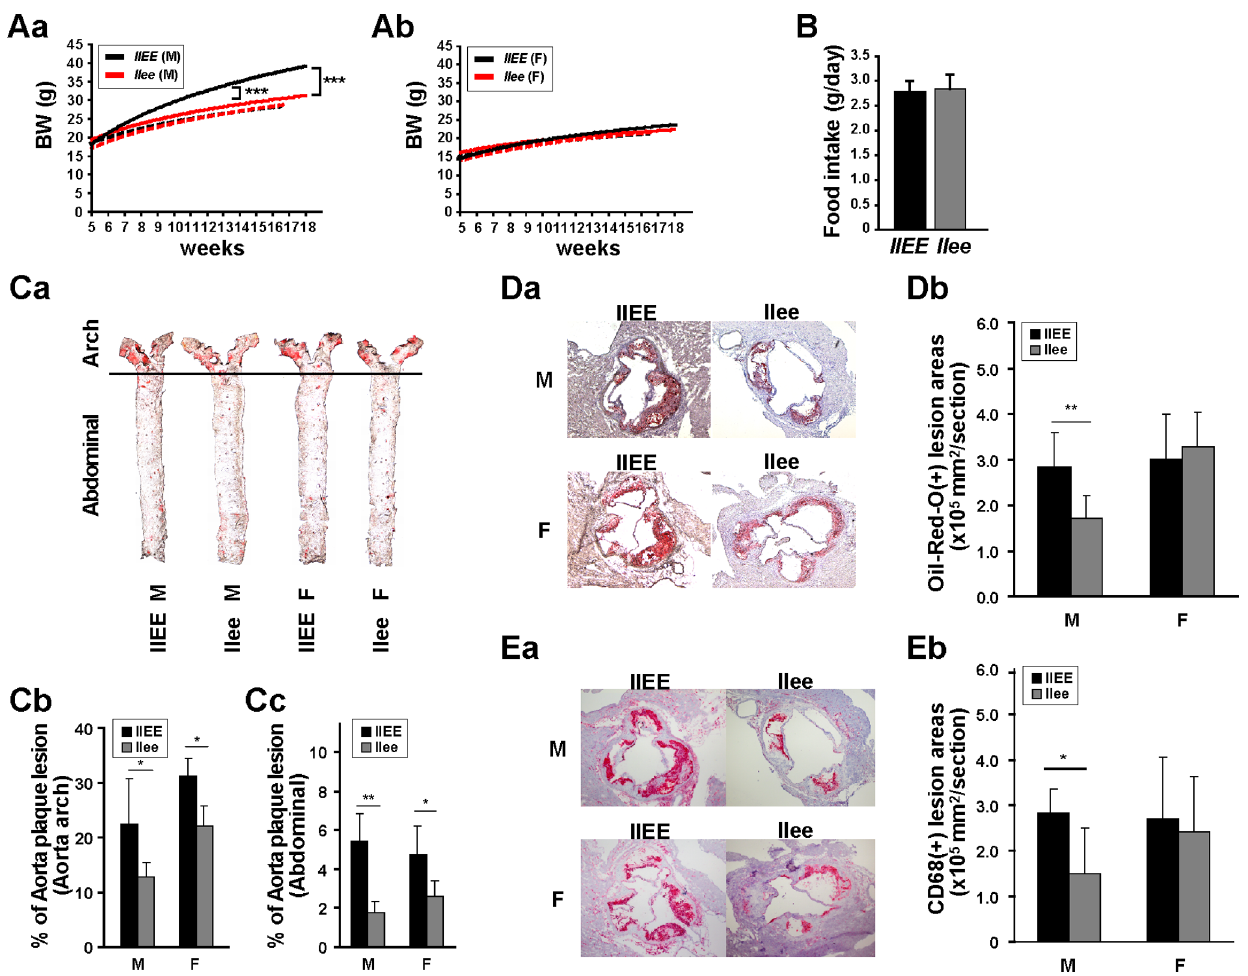
Figure 2. Characterization of body weight and atheroma development. A , Overall average body weights, during either a high cholesterol diet (HCD) or regular diet are shown using approximated curves in male (M, [ a ]) and female (F, [ b ]) mice. Mice were weighed twice per week. Each HCD group had more than 10 mice and regular diet group had more than 4 mice. Black line, Ldlr 2 / 2 ( llEE ); red line, Ldlr 2 / 2 /Cebpe 2 / 2 ( llee ) mice; solid line, HCD fed mice; dashed line, regular diet fed mice; BW, body weight; g, gram. B , Average amount of food intake (grams per day per mouse) in male llEE and llee mice on a HCD. C , C/EBP e deficiency reduces the extent of aortic atherosclerosis. Aortas of both male and female mice of either Ldlr 2 / 2 ( llEE ) or Ldlr 2 / 2 /Cebpe 2 / 2 ( llee ) genotype were fed a HCD for 12 weeks. ( a ) Aortas were stained for lipid deposition with Oil red O. Representative aortas from the groups are shown. Quantification of plaque areas in the aortas of either arch ( b ) or abdominal ( c ) lesion in either llEE or llee mice stained for lipid deposition with Oil red O. The area of the plaque lesions were quantified with Image-Pro Plus software. Means and SD of plaque areas are shown. D , Lipid content in aortic sinus plaques is reduced in llee male mice. ( a ) Representative Oil red O staining of aortic sinus from llEE and llee mice. ( b ) Quantitative analysis of ( Da ) lipid content in the aortic sinus. E , Macrophage infiltration in aortic sinus plaques is reduced in llee male mice. ( a ) Representative CD68 staining of aortic sinus from llEE and llee mice. ( b ) Quantitative analysis of ( Ea ) CD68 positive lesion in aortic sinus. Means and SD of plaque areas are shown. M, male; F, female. Data represent mean 6 SD. * P , 0.05, ** P , 0.01, *** P ,